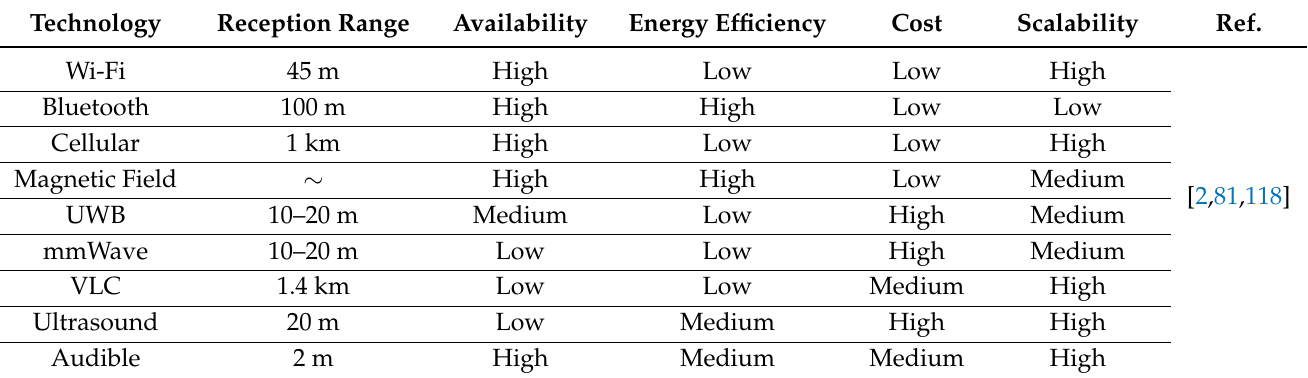
Table 7. Comparison of 3D Indoor Positioning Technology